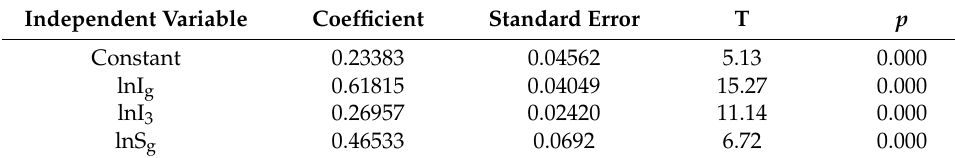
Table 2. Best subsets regression